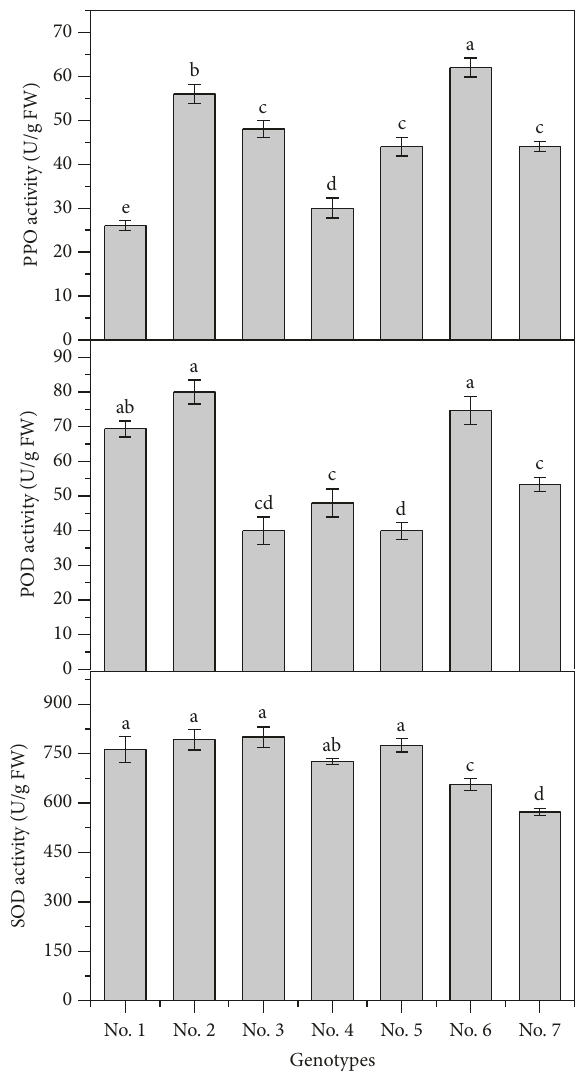
Figure 2: Enzymatic activity of PPO, POD, and SOD in Chinese dwarf cherry genotypes ( Cerasus humilis (Bge.) Sok.). Numbers 1–7 indicate different genotypes. Different letters indicate significant differences ( 𝑝 < 0.05 ). Data are expressed as mean ± SD ( 𝑛 = 3